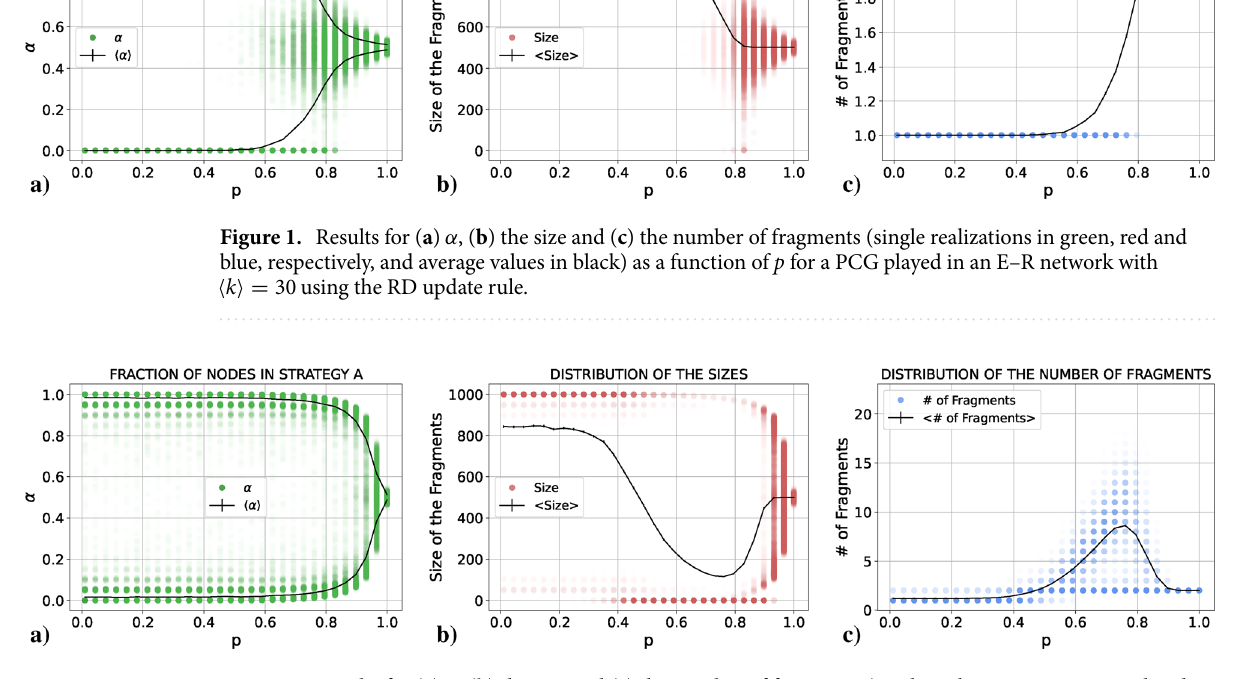
Figure 2. Results for ( a ) α , ( b ) the size and ( c ) the number of fragments (single realizations in green, red and blue, respectively, and average values in black) as a function of p for a PCG played in an E–R network with � k � = 30 using the UI update